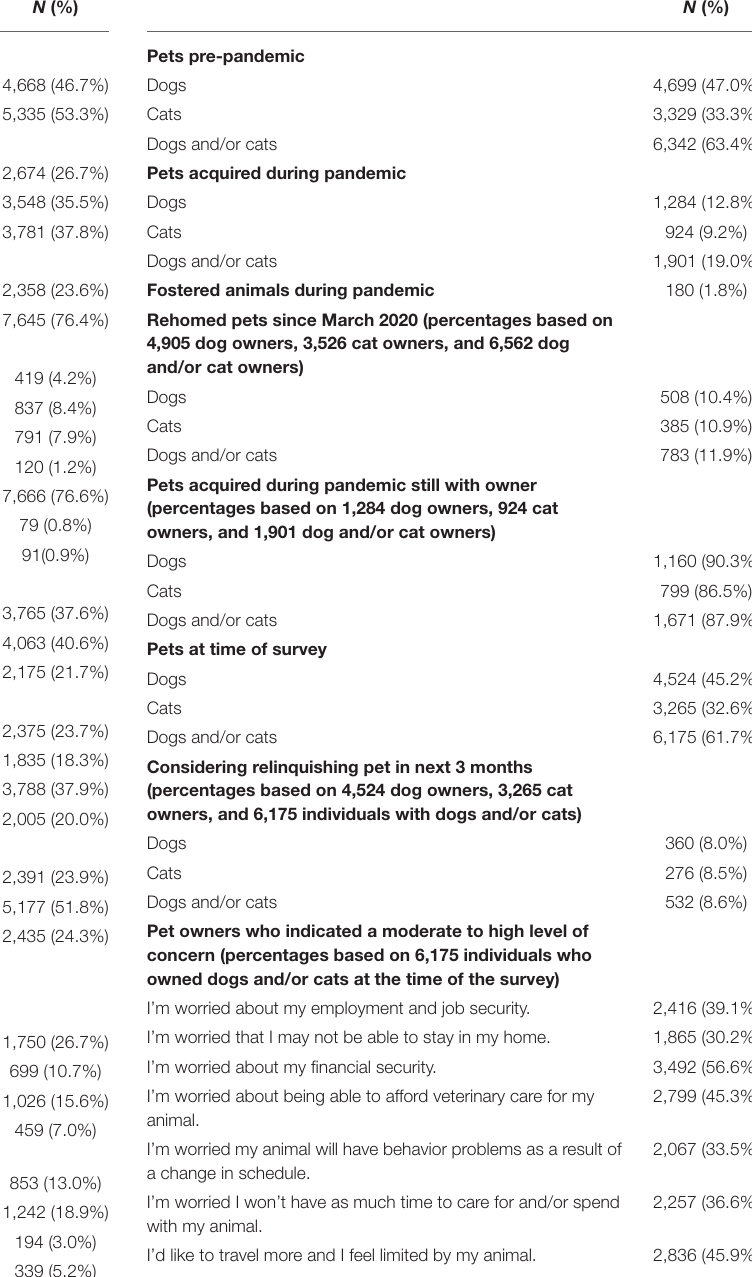
TABLE 1 | Description of the survey